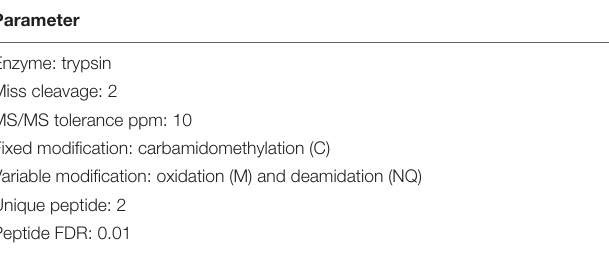
TABLE 2 | Parameters required for